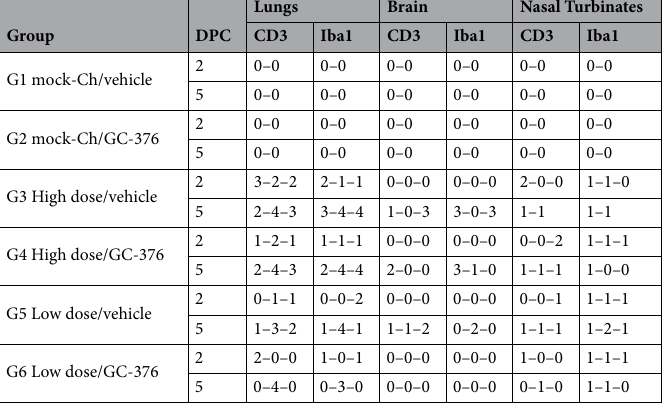
Table 2. CD3 and Iba1 IHC scores of different treatment groups. A dash (–) is used to separate the score of each individual mouse evaluated in each case.